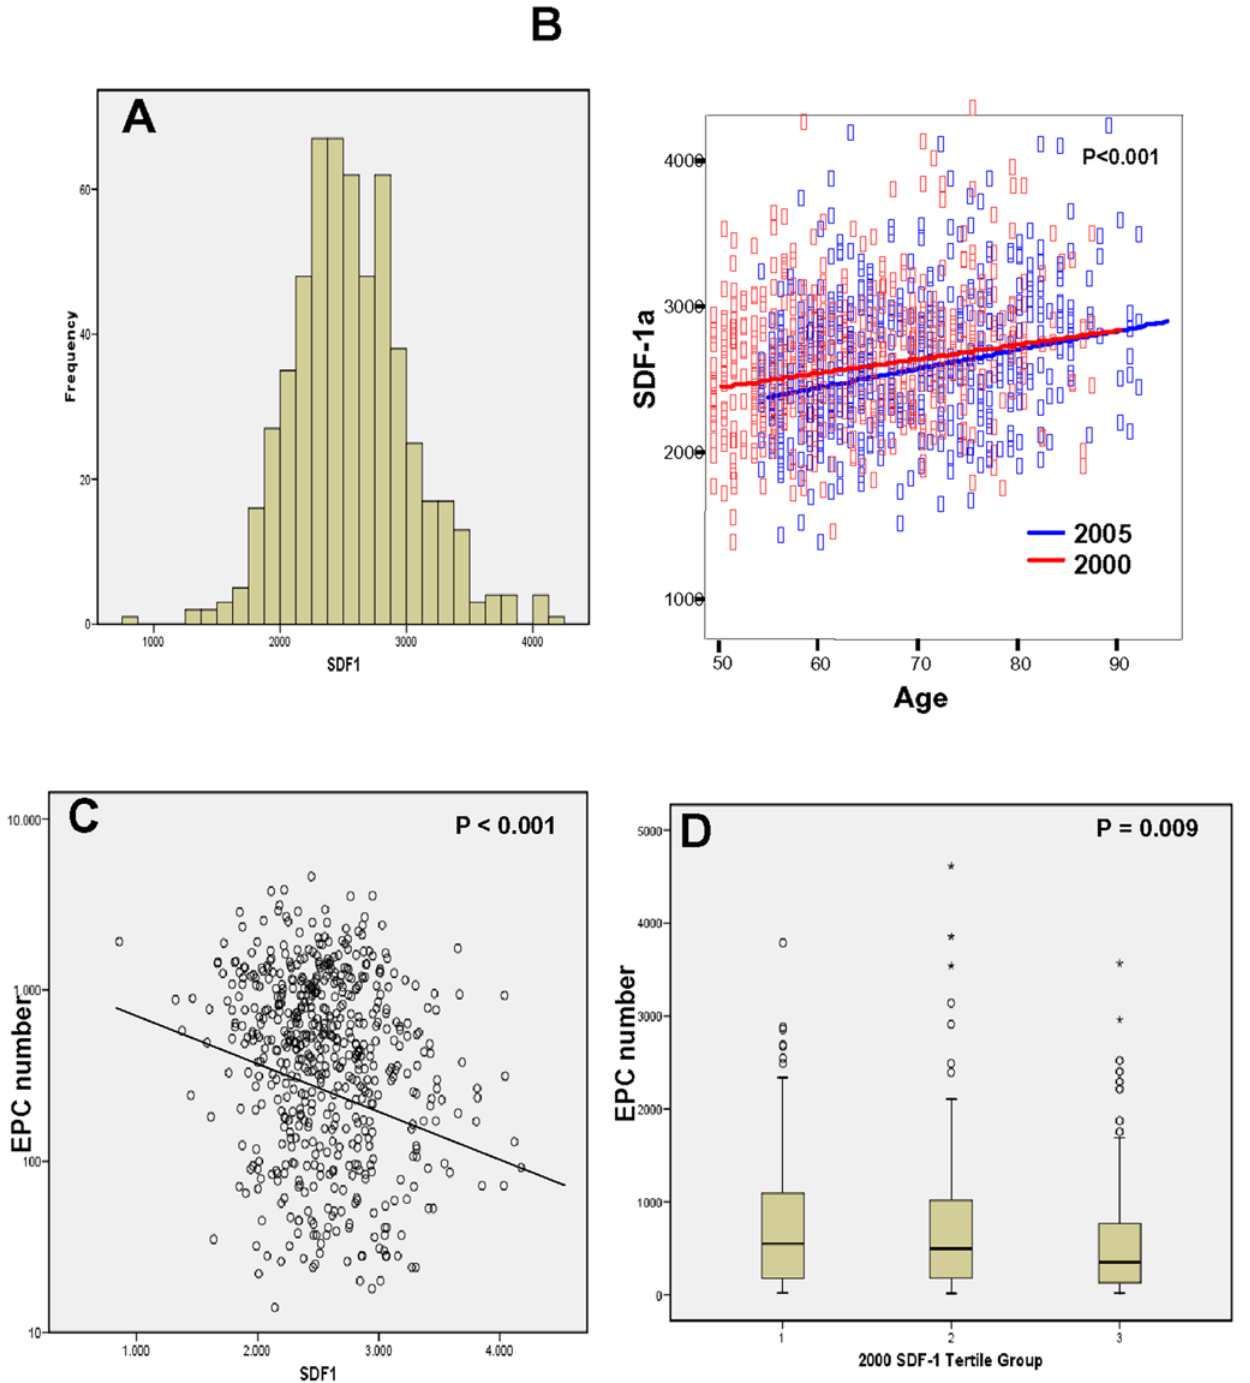
Figure 1. Panel A shows near normal distribution of SDF1 a in the Bruncek study population. Panel B displays the association between SDF-1 a measured in 2000 and in 2005 and age (r=0.270, p , 0.001). Panel C illustrates the correlation between SDF1 a levels and EPC number in 2005. The regression line demonstrates clearly that SDF1 a levels are inverse association with EPC number. Panel D illustrates the association between EPC numbers in 2005 and SDF1 a level in 2000 (tertile groups). SDF-1 tertile groups are defined as follows: T1 , 2409, T2 2409–2753 and T3 . 2753. The box plots indicating EPC number median and IQRs. Notably, EPC numbers are significant associated inversely with SDF-1 a levels, especially much low EPC number were likely observed in the top tertile group of SDF-1 levels.